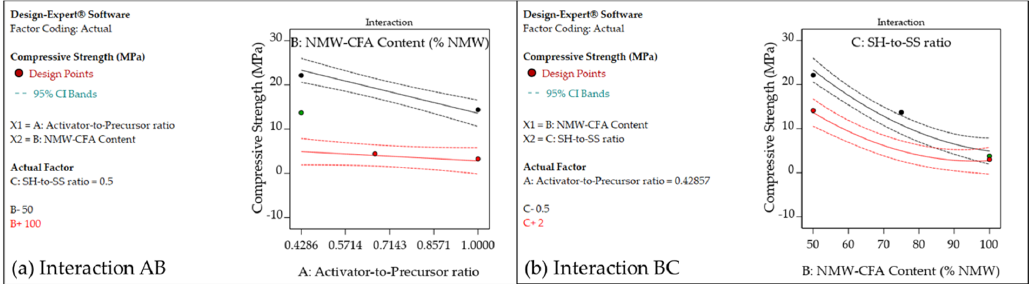
Figure 5. One ‐ factor plot.